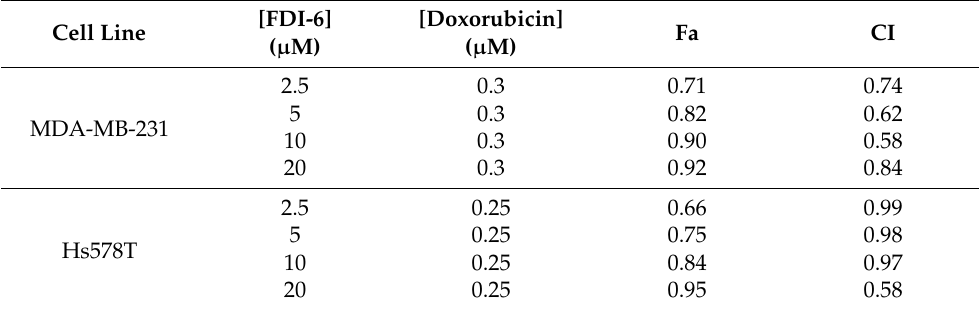
Table 1. CI analysis of FDI-6 combined with doxorubicin used to treat TNBC cells using Com- puSyn